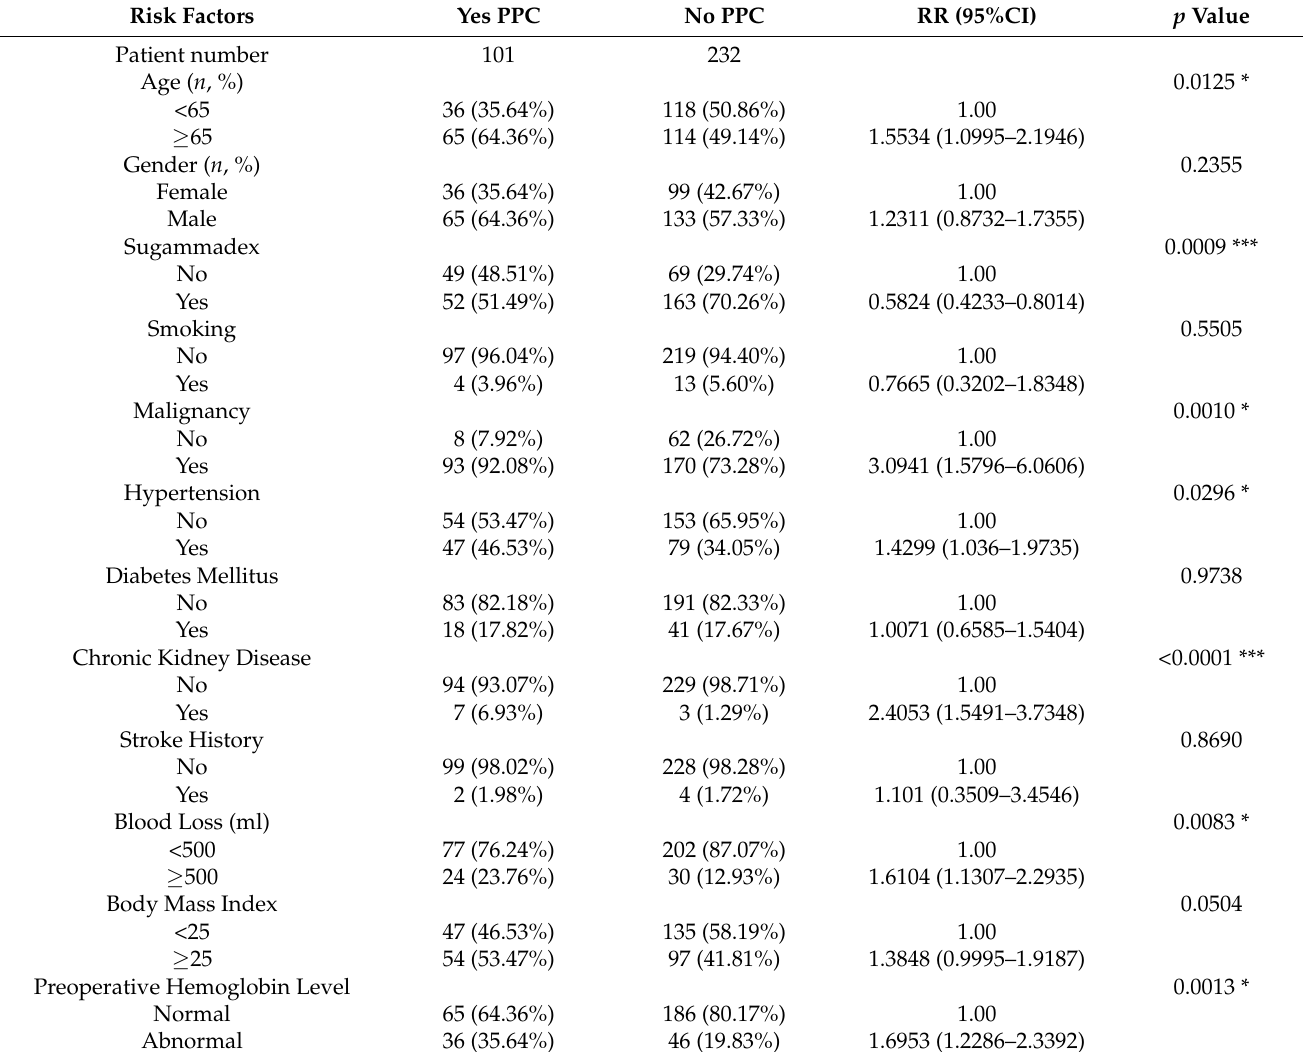
Table 4. Risk factors for postoperative pulmonary complications.